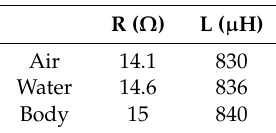
Table 2. Calculated values of Z-Matrix.